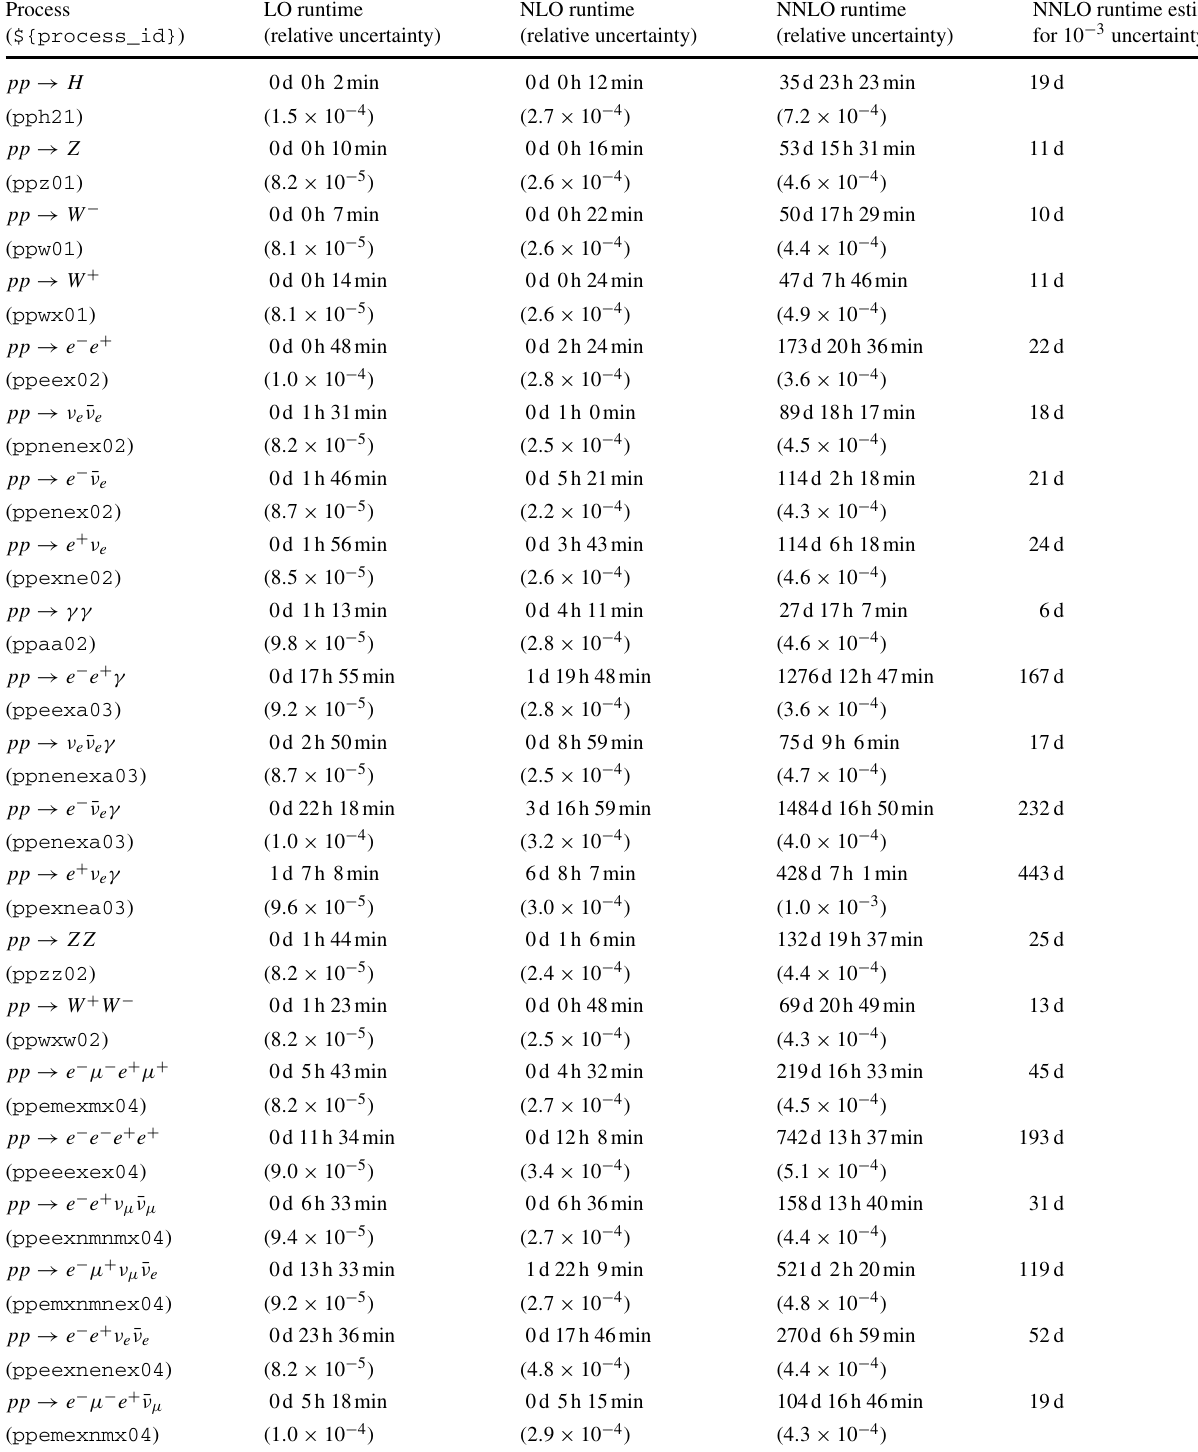
Table 11 Matrix runtime for integrated cross-section results in Table 6. The relative uncertainty is entirely due to the numerical phase space integration. The runtimes correspond tothe totaltime required for the production phase ( pre-run and main-run ) of the respective Matrix